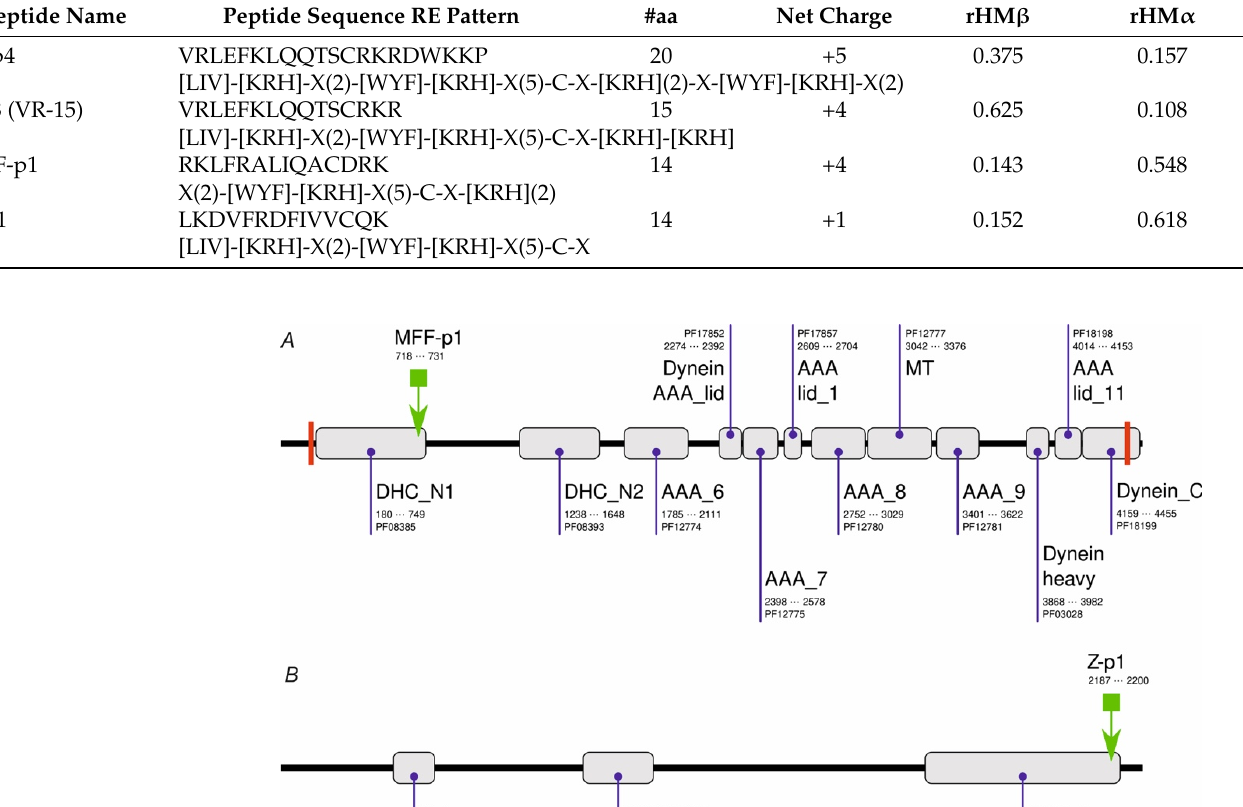
Table 1. Sequence and selected properties of peptides; chemerin-p4 (ch-p4), chemerin-8 (ch-8) (VR-15), MFF-p1 and Z-p1. For each peptide, the amino acid sequence and corresponding RE pattern, amino acid length (#aa), and net charge (at neutral pH) are given. rHM β and rHM α are relative hydrophobic moments calculated assuming the fully extended ( β -strand) and α -helical conformation, respectively.